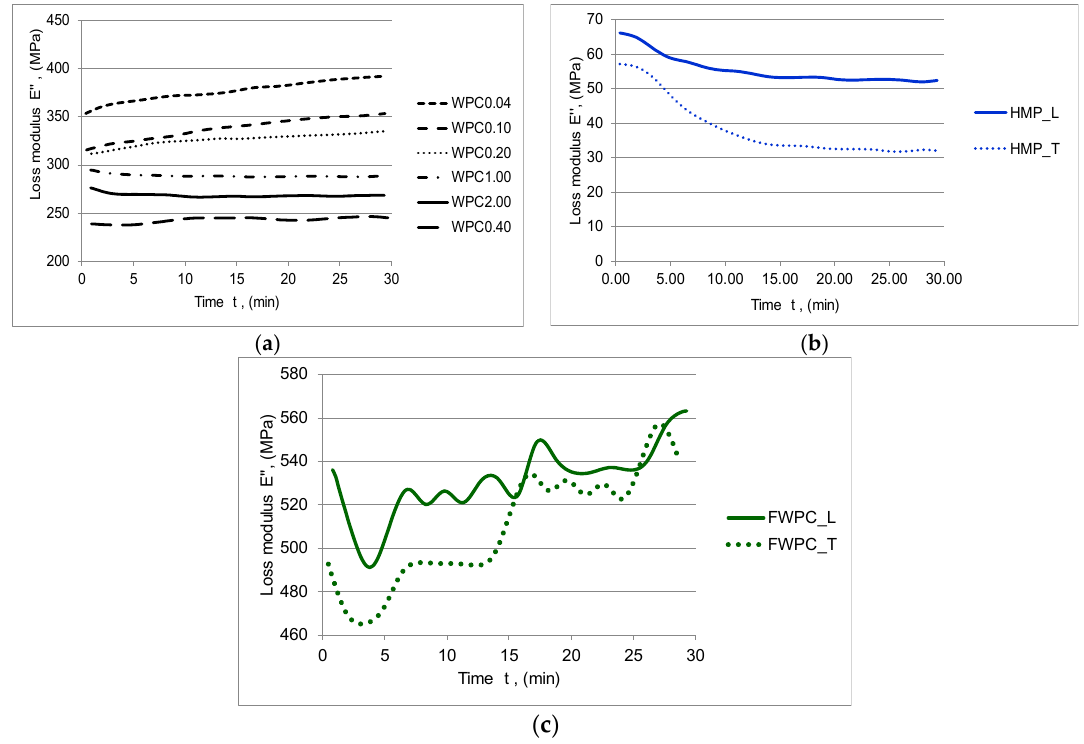
Figure 10. Variation of the loss modulus E” in time: ( a ) WPC samples; ( b ) HMP samples; ( c ) FWCP samples.